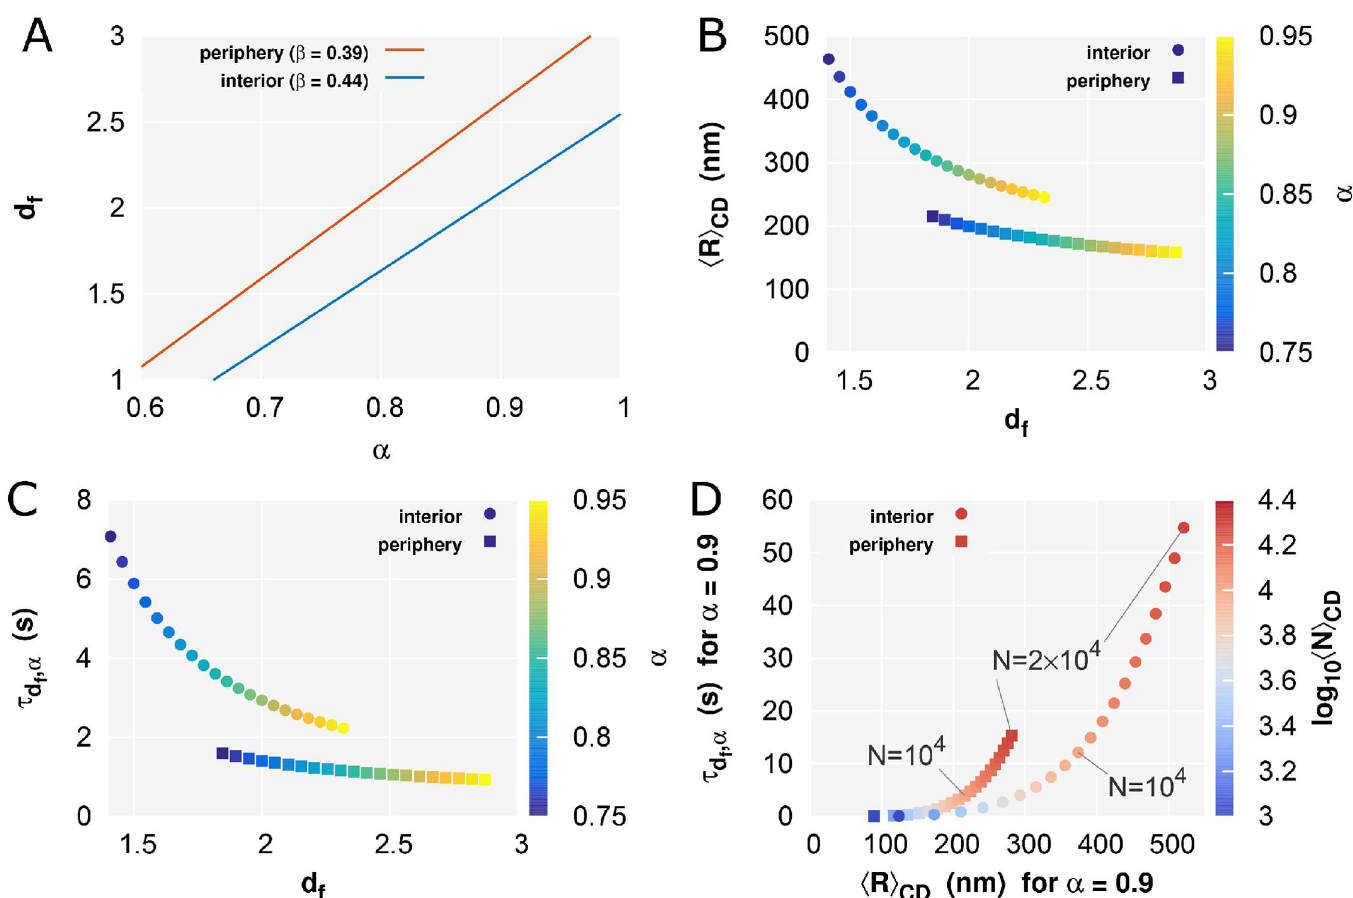
Fig 3. Structural information of CDs provided by single-nucleosome dynamics. (A) The fractal dimension d f within the nuclear interior region ( β = 0.44) and the peripheryregion ( β = 0.39) for α , accordingto Eq 16. (B) d f and the size h R i CD of CDs, and (C) d f and the relaxationtime τ d within the nuclear interior region (colored circle) and the periphery region (colored square) calculated for various α values, accordingto Eqs 16, 17 and 18. (D) h R i CD and the τ d within the nuclear interior region (colored circle) and the periphery region (colored square) calculated for α = 0.9 and various h N i CD f , α values, corresponding to the range of 200 kb to 4 Mb, accordingto Eqs 17 and 18.